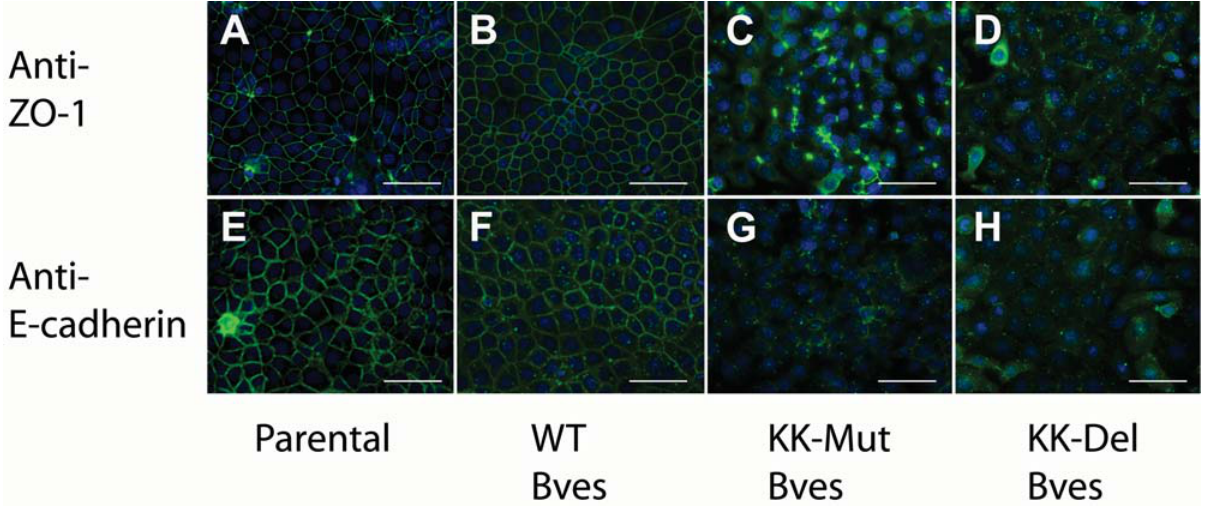
Figure 7. Expression of ZO-1 and E-cadherin in HCE cells. A, E, Parental HCE cells B, F, HCE cell lines transfected with WT Bves, C, G, KK-Mut Bves, and D, H, KK-Del Bves were stained with ZO-1 in panels A through D and E-cadherin in panels E through H. Note the loss of peripheral ZO-1 and E-cadherin staining in KK-Mut Bves and KK-Del Bves cells. (Scale Bar 100 m m)